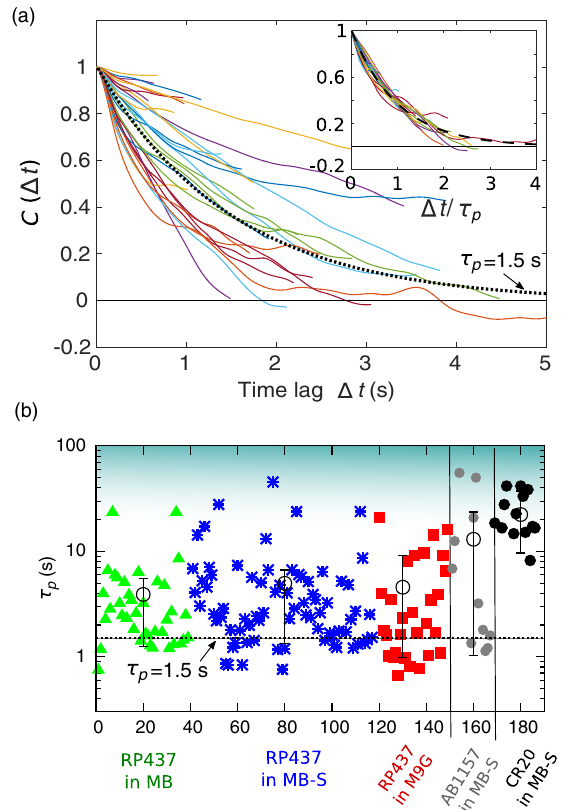
FIG. 3. Swimming orientation correlations. Experiments I. (a) Correlation function C ð Δ t Þ obtained for 30 tracks of different RP437 bacteria in M9G, showing a large distribution of persist- ence times. The correlation functions are fitted with an expo- nential decay exp ð − τ = τ p Þ to extract the persistence times τ p . The dotted line corresponds to τ p ¼ 1 . 5 s as expected from Ref. [1]. Inset: Correlation functions as a function of Δ t rescaled by τ p . The dashed line is exp ð − x Þ . (b) Persistence times for individual bacteria of wild-type strains RP437 and AB1157 and smooth swimmer mutant CR20 in different media (MB, MB-S, and M9G). Circles and uncertainty bars correspond to the mean and 68% confidence intervals for each group. The blue background region designates the cutoff from Brownian diffusion. The dotted line corresponds to the expected τ p ¼ 1 . 5 s also represented in (a). Uncertainty bars indicate the mean and confidence interval at